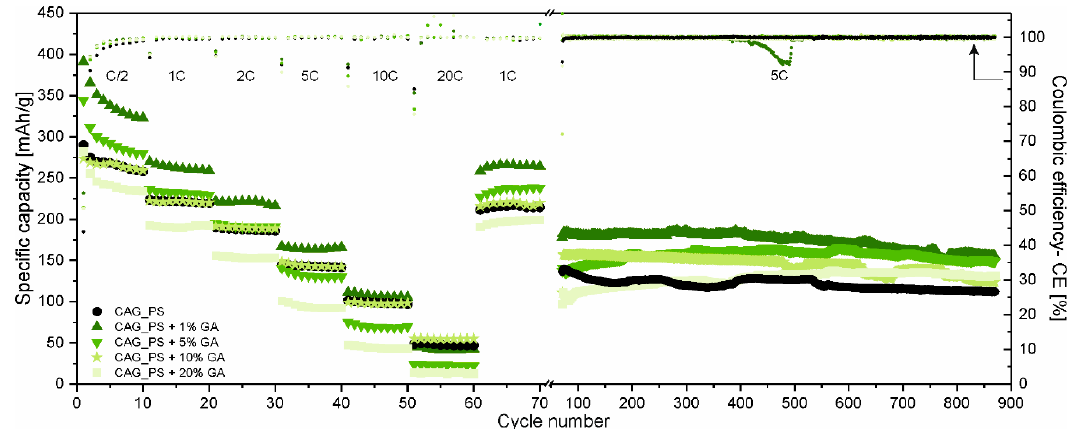
Figure 2. Galvanostatic charge–discharge tests under the different current loads with the additional long-term cycling for GA-structured carbon aerogels.